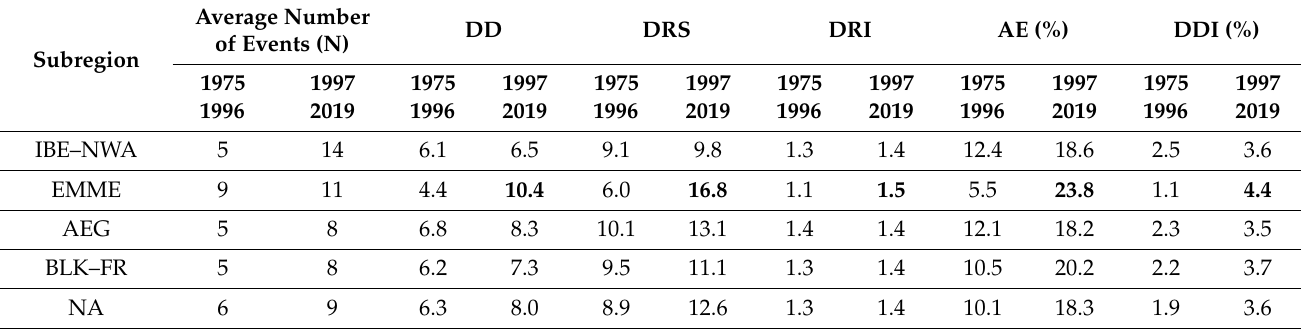
Table 8. Subregional drought parameters for two subperiods according to the